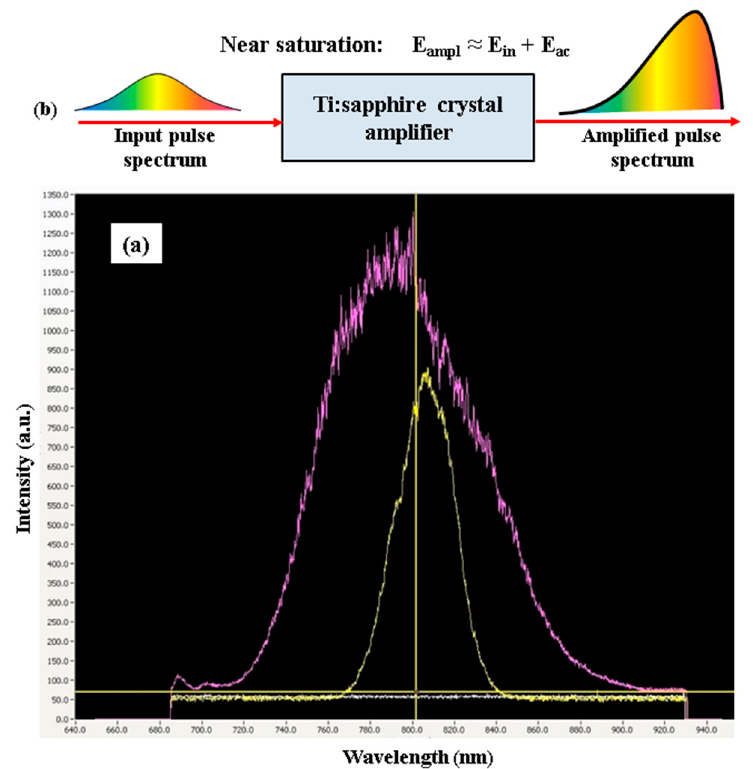
Figure 10. Gain narrowing and red-shifting in Ti:sapphire amplifiers. ( a ) Spectrum narrowing and red-shifting of the amplified stretched pulse in a 10-TW laser system (TEWALAS, 350 mJ output pulse energy, 30 fs pulse duration, 10 Hz pulse repetition rate, Amplitude Technologies, at the National Institute for Laser and Plasma Radiation Physics, Bucharest-Magurele); cyan curve, femtosecond oscillator spectrum; yellow curve, amplified pulse spectrum. ( b ) Schematic description of the red shifting effect in a nearly-saturation operated Ti:sapphire amplifier.